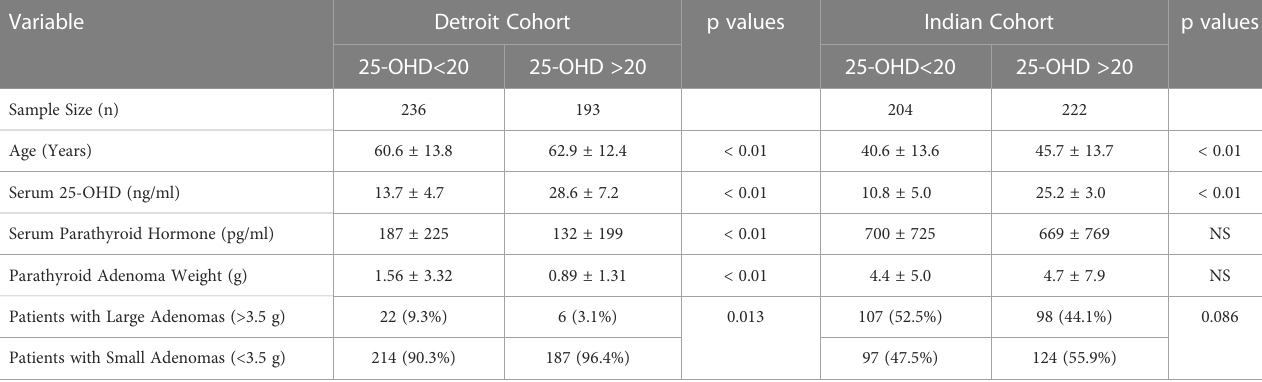
TABLE 4 Prevalence of large and small parathyroid adenomas in the two secularly diverse cohorts (Detroit, USA and Chandigarh, India) strati fi ed by serum 25-hydroxyvitamin D levels. Variable Detroit Cohort p values Indian Cohort p values 25-OHD<20 25-OHD >20 25-OHD<20